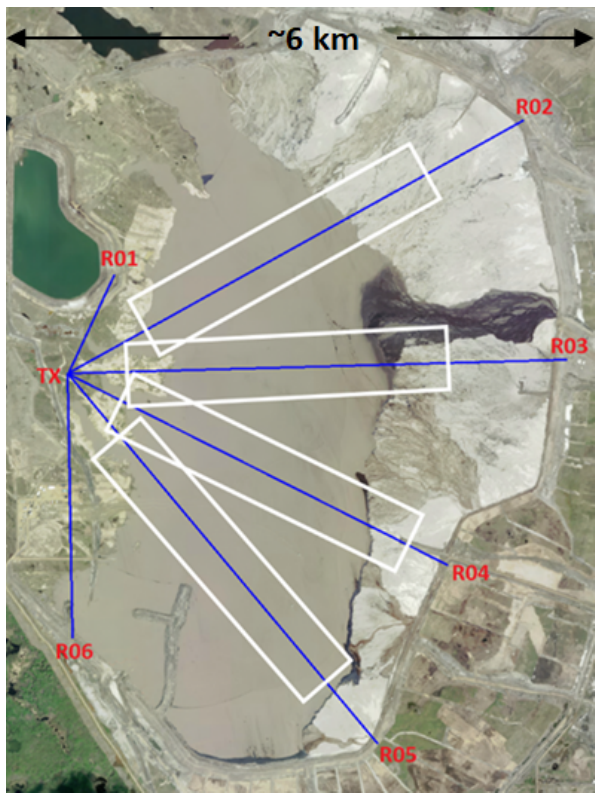
Figure 1. GreenLITE ™ system configuration at the tailings pond. Simulated area emission sources (white rectangles) used in the SCI- CHEM modeling scheme. (Image credit: CNRL,